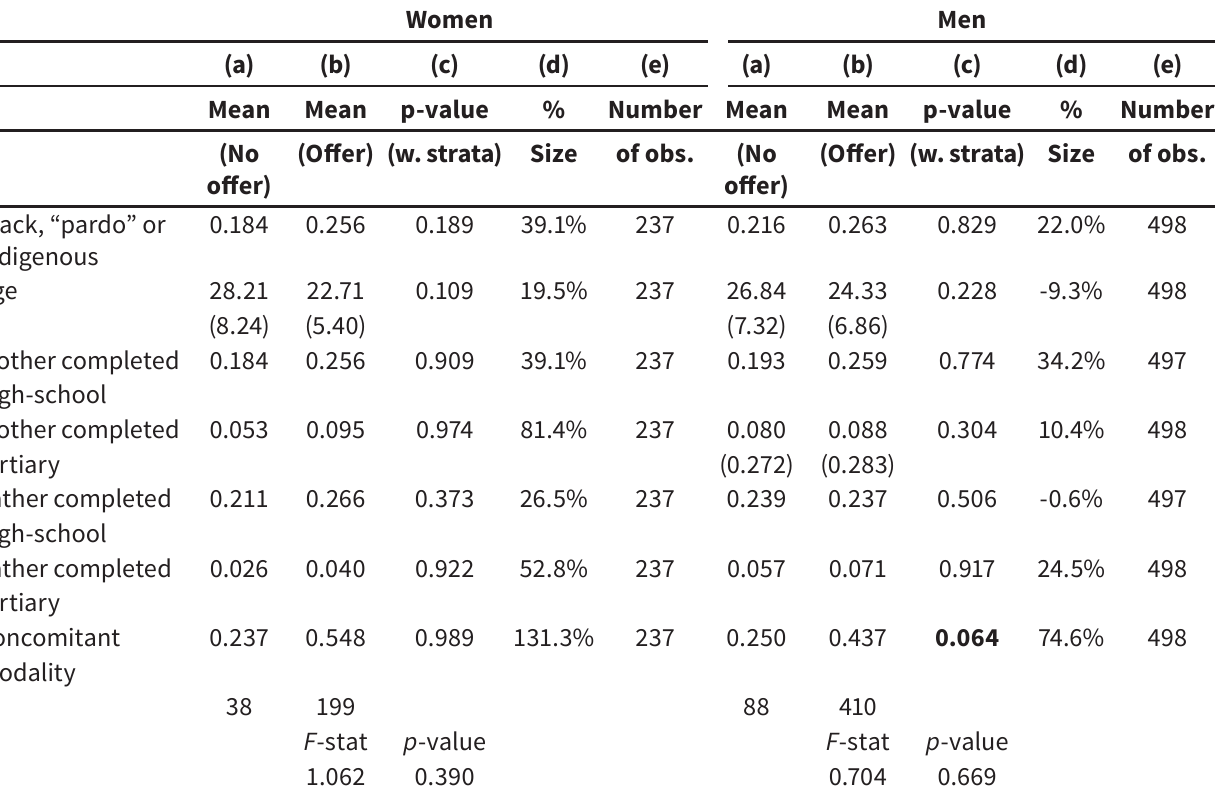
Within-Strata Balance Across Treatment Offer Arms, All Interviewed Subscribers by Gender Group